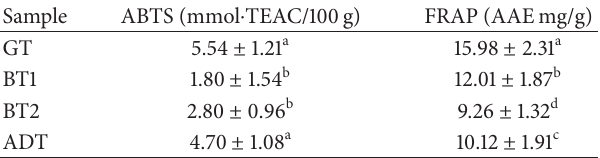
Table 1: 2,2-Azizobis (3-ethylbenzothiazoline ∼ 6-sulfonate) “ABTS” scavenging ability and ferric reducing antioxidant property of some commercial